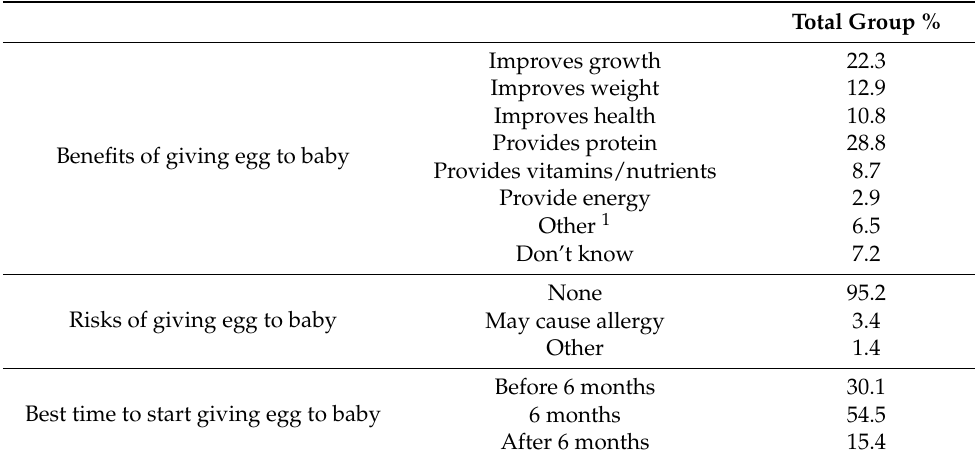
Table 8. Respondents’ perceptions regarding the benefits and risks of giving egg to the baby, expressed as a percentage of respondents who completed the exit